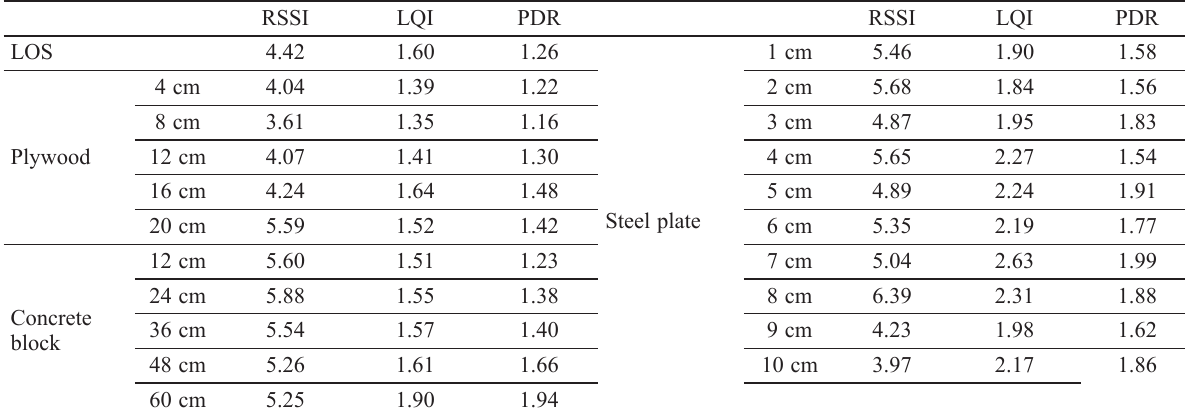
Table 3. Shape parameter of the beta in the beta probability distribution according to materials and thickness (alpha = 2.0)